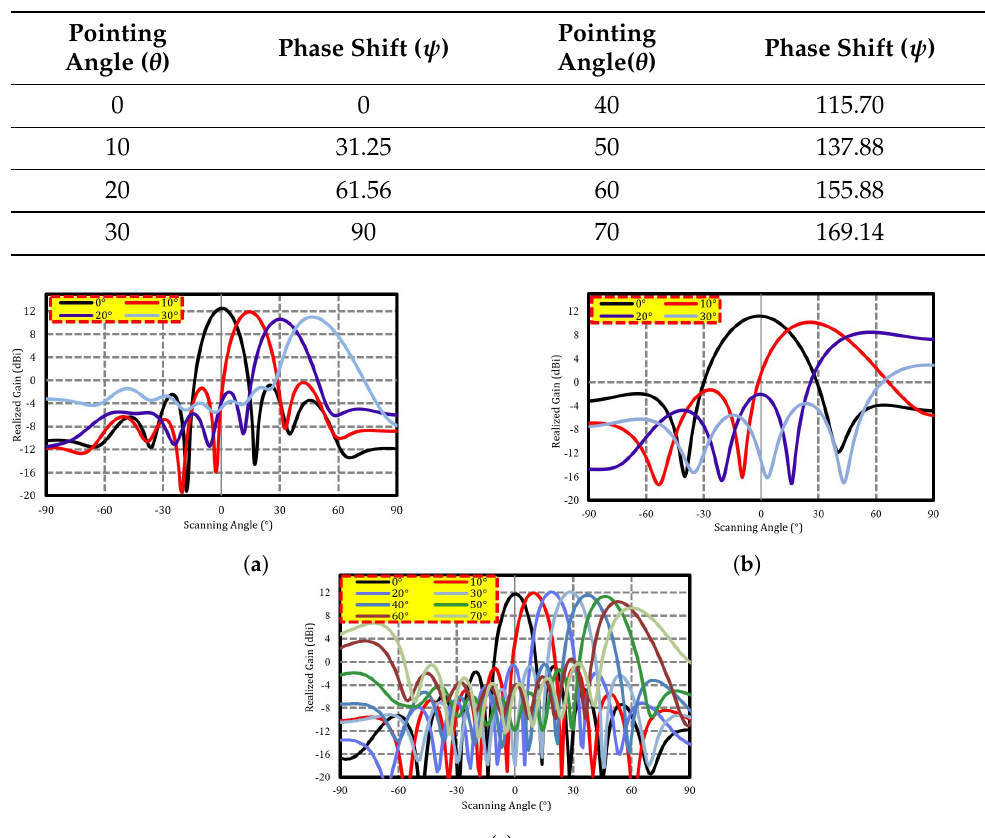
Table 2. Pointing angle vs. phase shift.